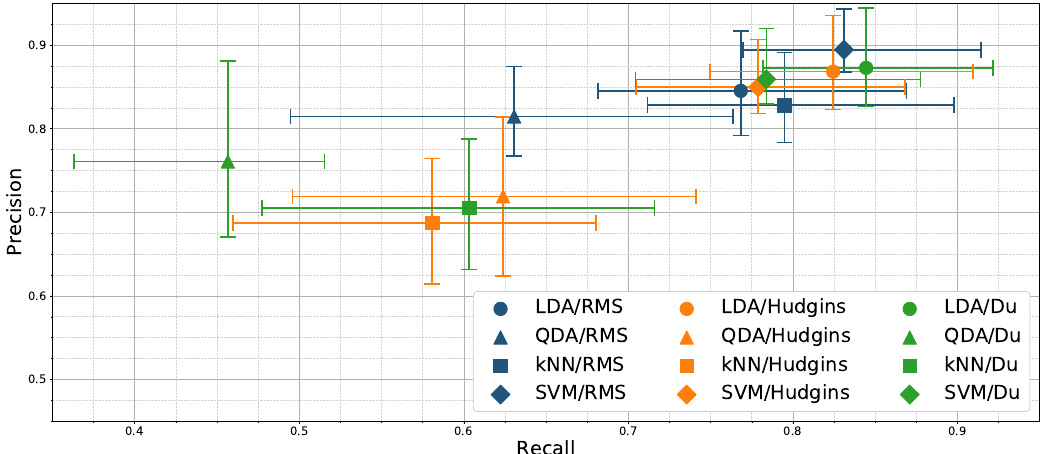
Figure 7. Classification precision and recall mean relationship for different classifiers and feature sets combinations; error bars mark 25th and 75th percentile; results presented for 24 channel